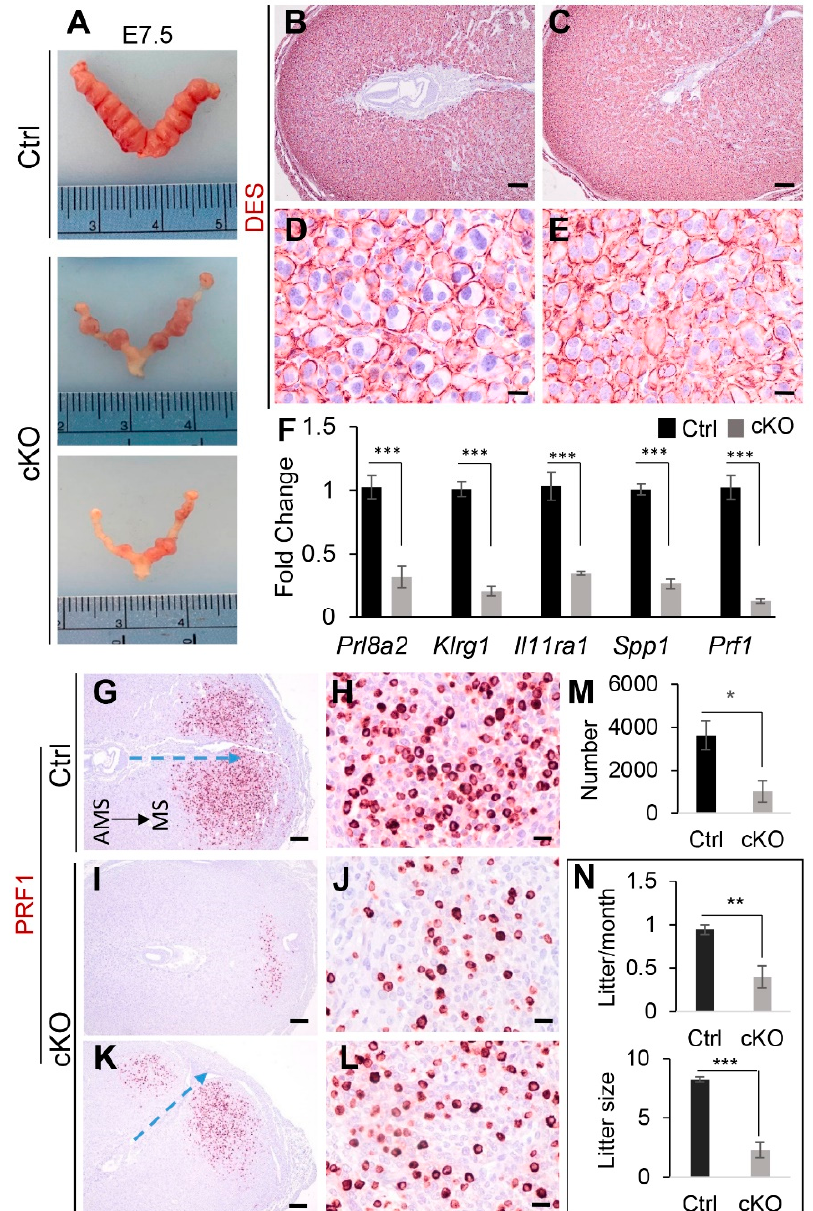
Figure 7. Impaired embryo development and decidual integrity in Ezh2 Amhr2 -Cre cKO mice. ( A ) Embryo development in control and Ezh2 Amhr2 -Cre cKO mice at E7.5. ( B – E ) Immunostaining of DES using uteri from control and Ezh2 Amhr2 -Cre cKO mice at E6.5. At least three animals for each genotype were examined. Panels ( D , E ) are higher power images for panels ( B , C ), respectively. Scale bar = 20 µ m ( D , E ) and 200 µ m ( B , C ). ( F ) qRT-PCR analysis of Prl8a2 , Klrg1 , Il11ra1 , Spp1 , and Prf1 mRNA expression using implantation sites from control and Ezh2 Amhr2 -Cre cKO mice at E7.5. n = 6. Data are mean ± s.e.m, *** p < 0.001. ( G – L ) Immunostaining of PRF1 using implantation sites from control and Ezh2 Amhr2 -Cre cKO mice at E7.5. Panels ( I – L ) represent two implantation sites from different Ezh2 Amhr2 -Cre cKO mice. Panels ( H , J , L ) are higher power images for panels ( G , I , K ), respectively. At least three animals for each genotype were examined. MS, mesometrial side. AMS, antimesometrial side. Dashed blue arrows indicate embryonic-uterine orientation. Scale bar = 200 µ m ( G , I , K ) and 20 µ m ( H , J , L ). ( M ) Qualification of the number of PRF1-positive cells in control and Ezh2 Amhr2-Cre cKO mice at E7.5. n = 6. Data are mean ± s.e.m. * p < 0.05. ( N ) Subfertility in Ezh2 Amhr2 -Cre cKO mice during a 3-month breeding trial. n = 5–6. Data are mean ± s.e.m. ** p < 0.01 and *** p <